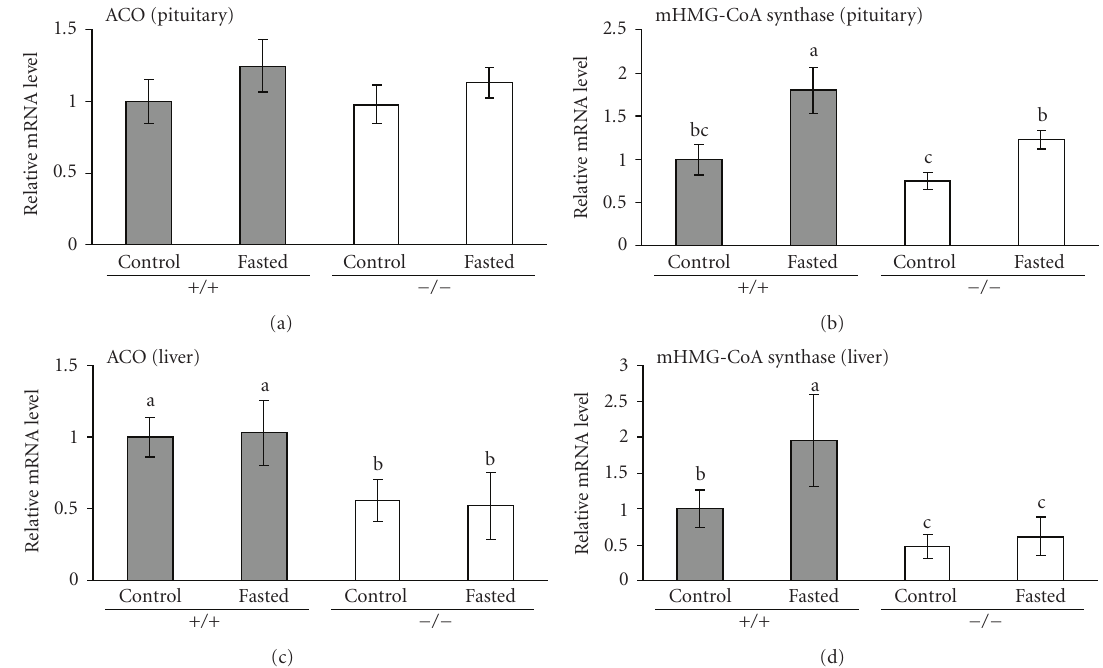
Figure 3: E ff ect of fasting on mRNA concentrations of acyl-CoA oxidase (ACO) and mitochondrial 3-hydroxy-3-methylglutaryl-(mHMG)- CoA synthase in pituitary gland and liver of wild-type (+ / +) and PPAR α knockout mice ( − / − ). Mice of both genotypes were either fasted for 48hours (control group) or fed a standard rodent diet ad libitum for 48 hours (fed group). Livers and pituitary glands of mice were excised, pituitary glands from two animals were pooled, total RNA was extracted, and mRNA abundances were determined by real-time detection RT-PCR analysis using β -actin for normalization. Bars represent means ± SD (liver: n = 10; pituitary: n = 5). Means without a common letter di ff er, P < . 05. Significant e ff ects ( P < . 05) from two-way ANOVA: mHMG-CoA synthase (pituitary): genotype, fasting, fasting